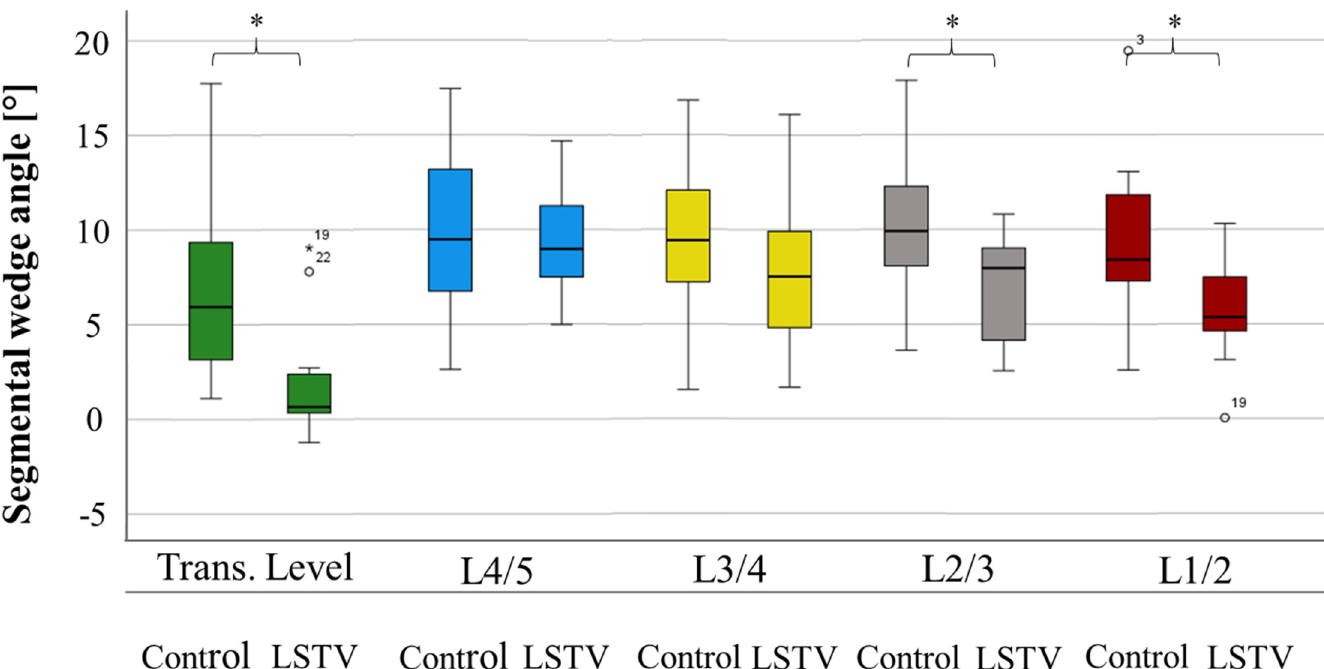
Fig 3. Segmental range of motion. Fig 3 compares the segmental range of motion based on the difference between segmental wedge angles in maximum ventral flexion and dorsal extension ( Δ ) of patients with LSTV and the control group. In the transitional segment, the range of motion between patients with LSTV and the control group differs significantly as well as in the L1/2 and L2/3 segment. Trans. Level = transitional vertebra level or level L5/S1 in patients without LSTV, Control = control group, LSTV = patient group with lumbosacral transitional vertebrae. The significance level was set at 0.05. Significant values are marked with an asterisk.